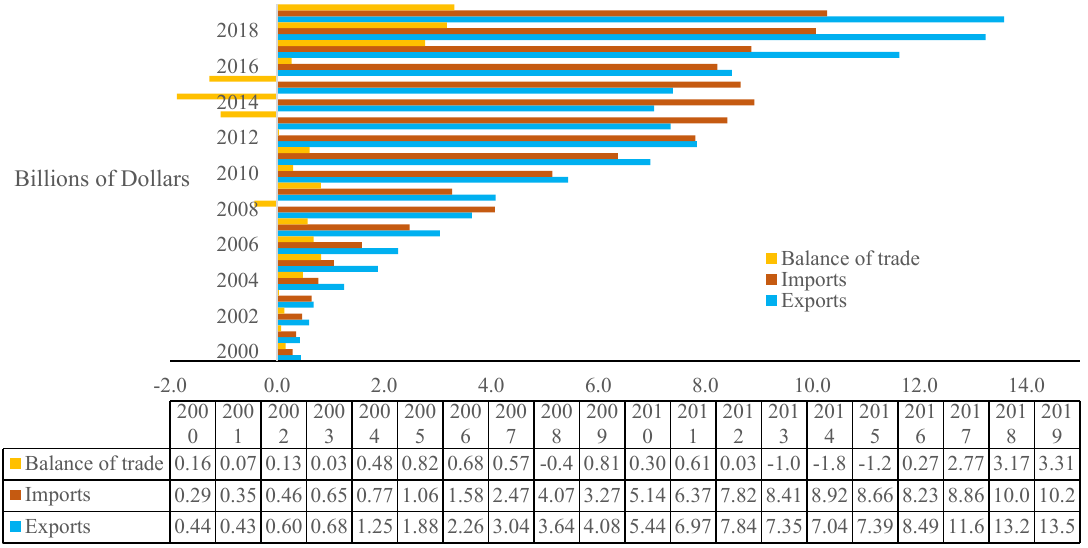
Fig. 1. Balance of Trade Peru - China 2000 - 2019 (USD Billions)